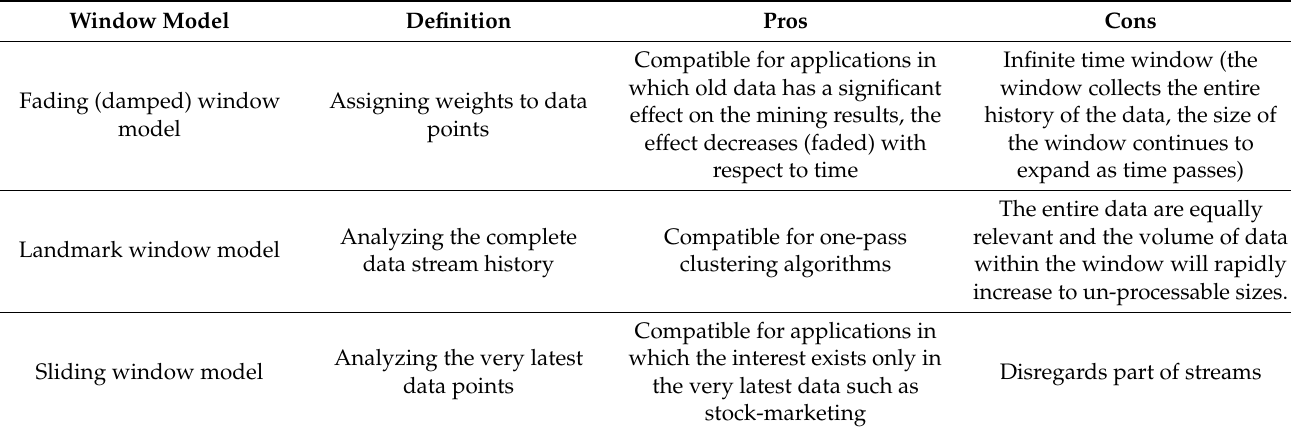
Table 3. Window models in clustering data